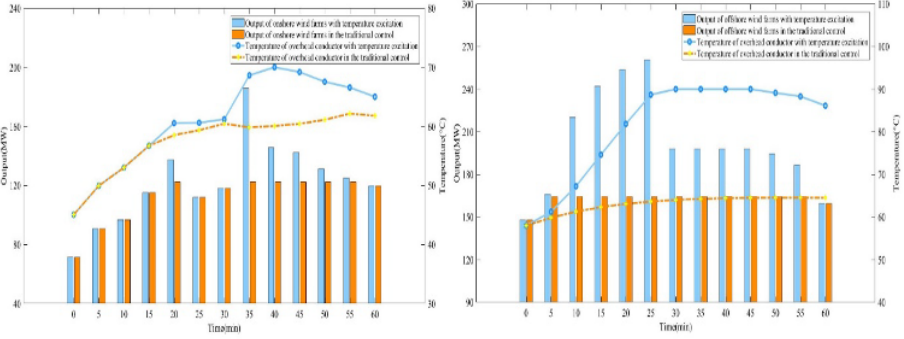
Fig. 3. Simulation results of onshore wind farms. Fig. 4. Simulation results of offshore wind